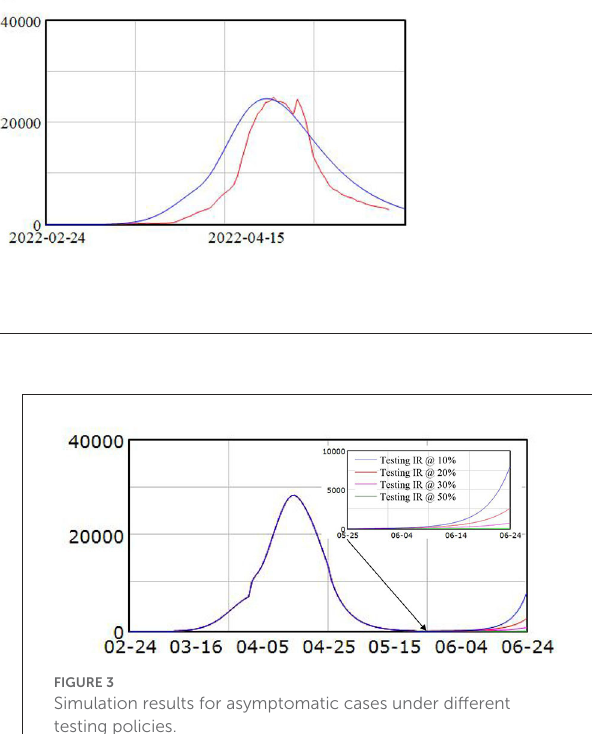
FIGURE3 Simulation results for asymptomatic cases under different testing